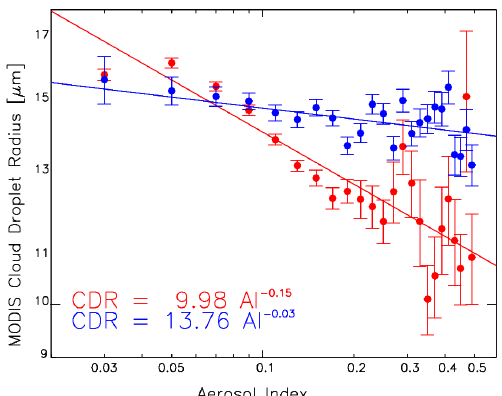
Fig. 5. Cloud Droplet Radius (CDR) retrievals averaged over constant bin of Aerosol Index (AI), in log-log scale, for cases of well- separated cloud and aerosol layers (blue) and mixed and interacting layers (red), in the region within [2 ◦ S–15 ◦ S; 14 ◦ W–18 ◦ E]. Error bars represent the confidence level of the mean values if one as- sumes independent data. They are calculated as σσ(n − 2)½, where n is the number of CDR measurements within the bin and σσ is their standard